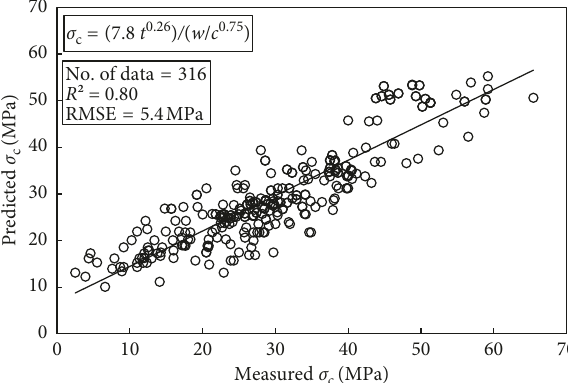
Figure 7: Relationship between measured and predicted com- pressive strengths for cement